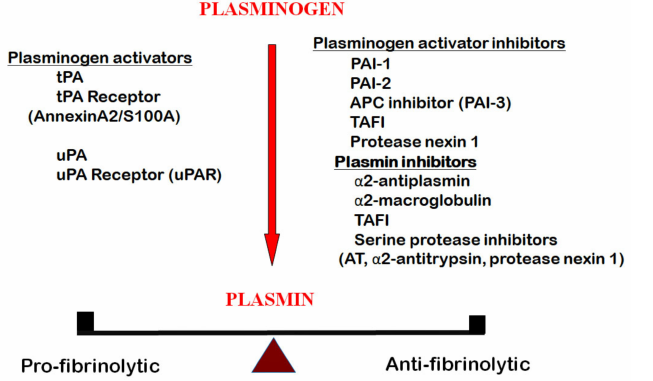
Figure 1. The fibrinolytic system, aka the plasminogen-plasmin system, consisting of the serine protease plasmin, derived from plasminogen by the activation of its activators, tissue plasminogen activator (tPA) and urokinase-type plasminogen activator (uPA). These two activators are ligands to their cellular receptors, urokinase receptor (uPAR) and a heterotetramer annexin, A2/S100A, respec- tively. The plasminogen activators and plasmin are inhibited by plasminogen activator inhibitors, plasminogen activator inhibitor 1 (PAI-1), plasminogen activator inhibitor 2 (PAI-2), activated protein C inhibitor (APC) inhibitor (PAI-3), thrombin activatible fibrinolysis inhibitor (TAFI) and protease nexin 1. Plasmin is inhibited by α 2-antiplasmin, α 2-macroglobulin, TAFI and several serine protease inhibitors (AT, α 2-antitrypsin, protease nexin